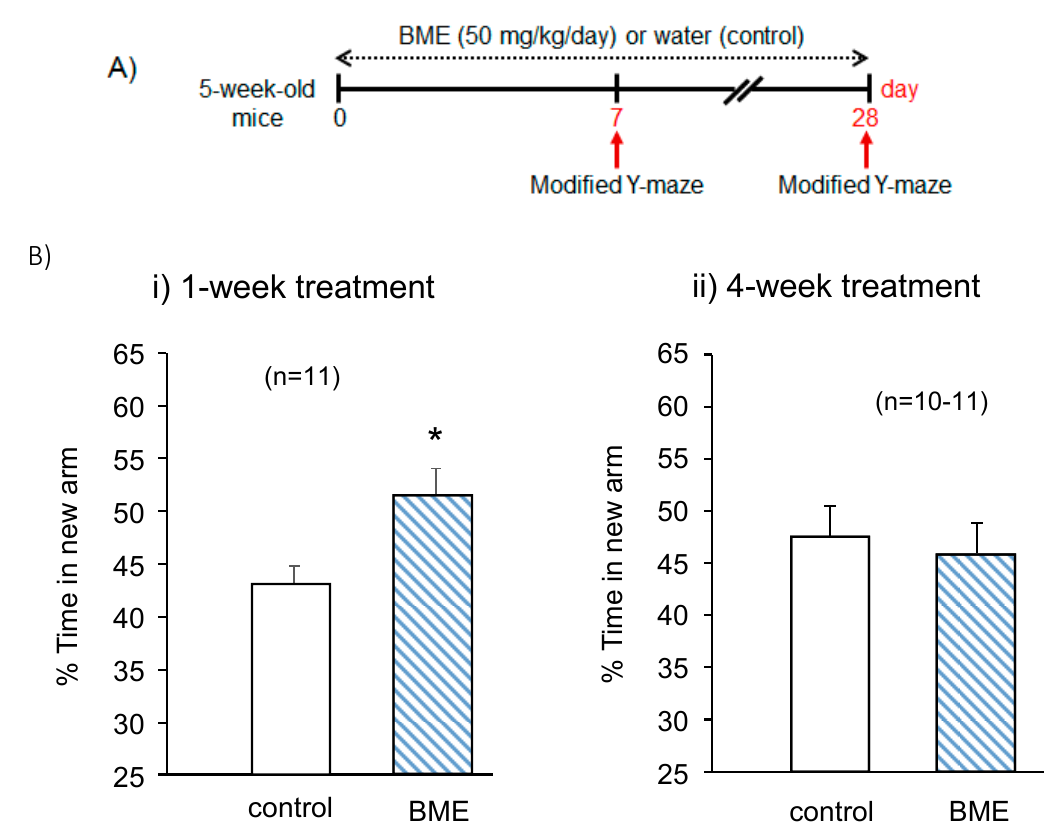
Figure 1. Effect of BME (50 mg/kg) on spatial working memory in adolescent mice after 7- and 28-day treatment. Spatial working memory was elucidated by the modified Y-maze test. Sample and test trials were conducted for 5 min with a 30-min interval (A). In the sample trial, each mouse was individually placed in the maze with one of the three arms closed. The arm that was closed in the sample trial was defined as the new arm in the test trial. Summarized data was obtained on days 7 and 28 after the BME treatment (B). Results are expressed as percent time animals spent exploring the new arm in the test trial. Each data column represents the mean ± SEM (n = 10–11). * p < 0.05 vs. the control group.